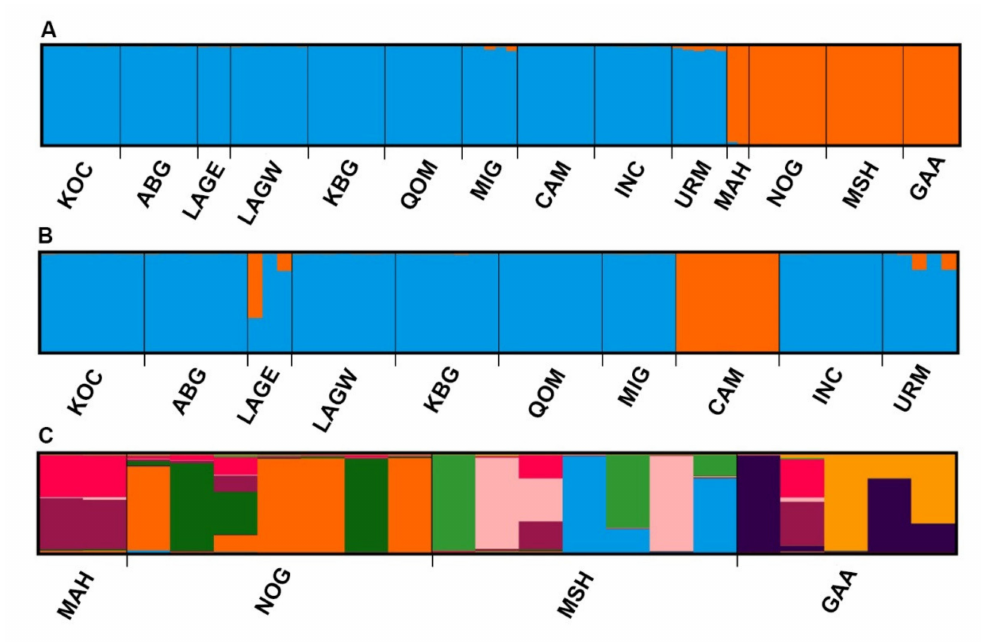
Figure 6. Clustering of genetic structures based on ISSR markers ( A = whole examined populations, B = native populations, C = invasive A. franciscana ; abbreviations listed in Table